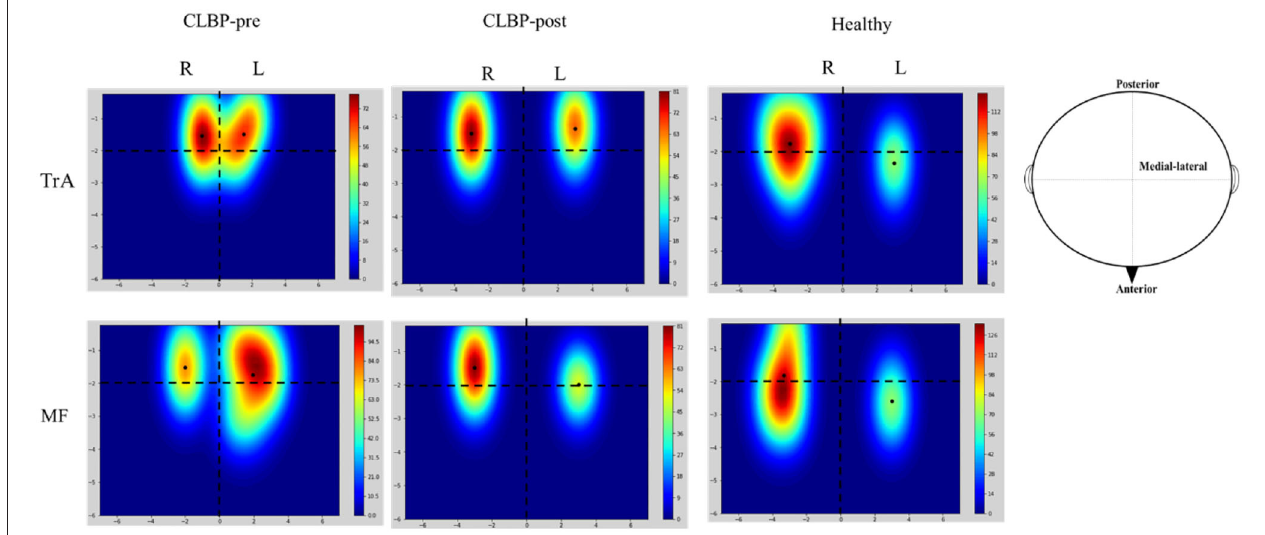
FIGURE 3 | Representative location and cortical excitation of the TrA and MF responses to TMS for the healthy and one patient with CLBP on the two hemispheres. These maps illustrate the spread of excitation across the scalp. The mean and SD of the CoGs are given in Table 3 . Colored bars indicate the strength of the mapping when considering the size and location of all the MEP responses. The black solid dots represent the location of CoG over the muscle. The horizontal dotted line denotes the interaural line and the vertical dotted line denotes the line that connects the nasion and inion and intersects at the vertex. The X-axis is the distance between medial-lateral and the Y-axis is the distance between anterior-posterior. CLBP, chronic low back pain; L, left; R, right; TrA, Transversus abdominis; MF, Multifidus.